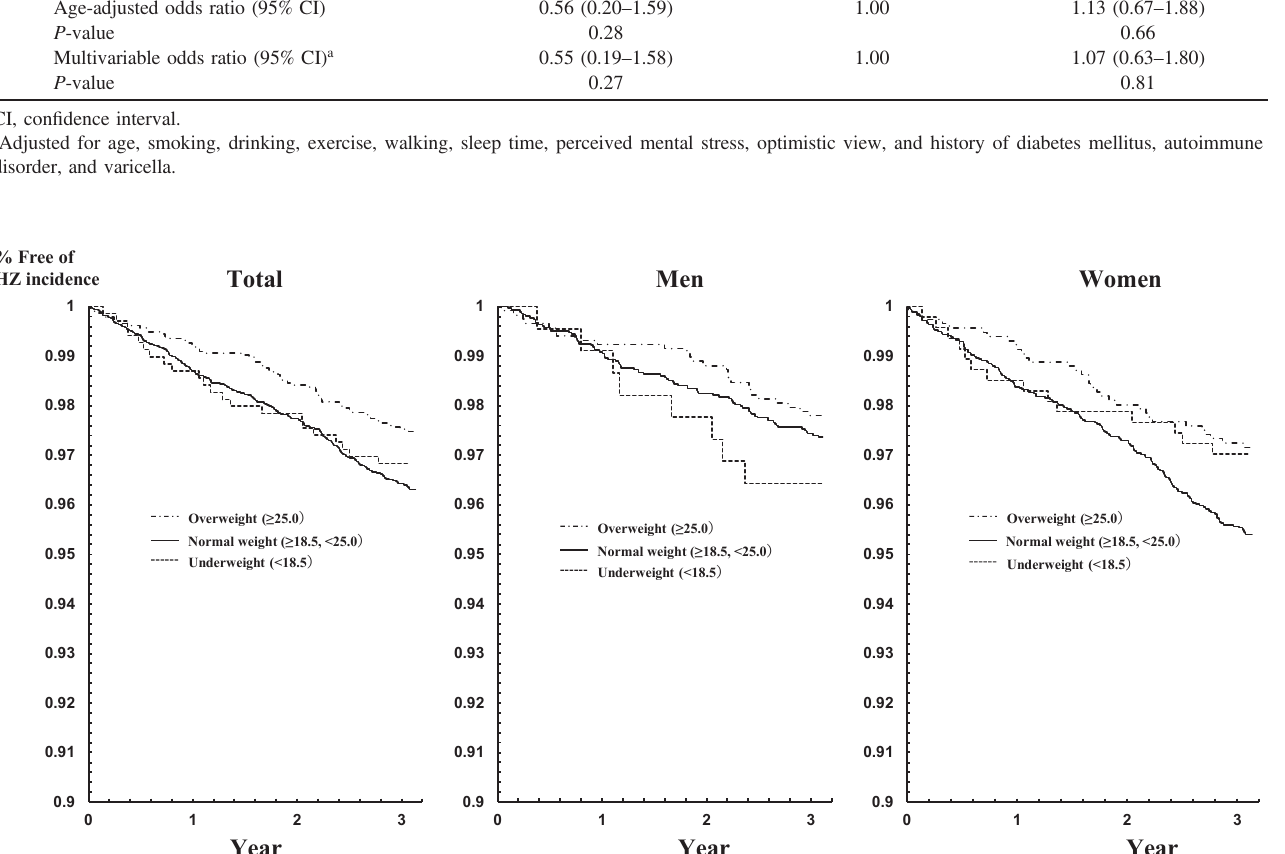
Body mass index (kg / m 2 ) Underweight Normal weight (<18.5) (18.5 to <25.0)